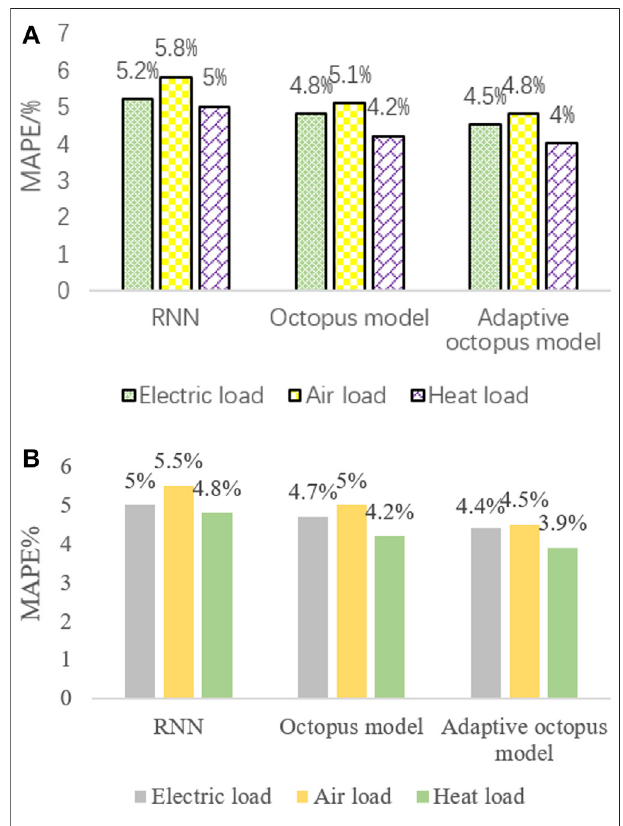
FIGURE 8 | Two prediction types of